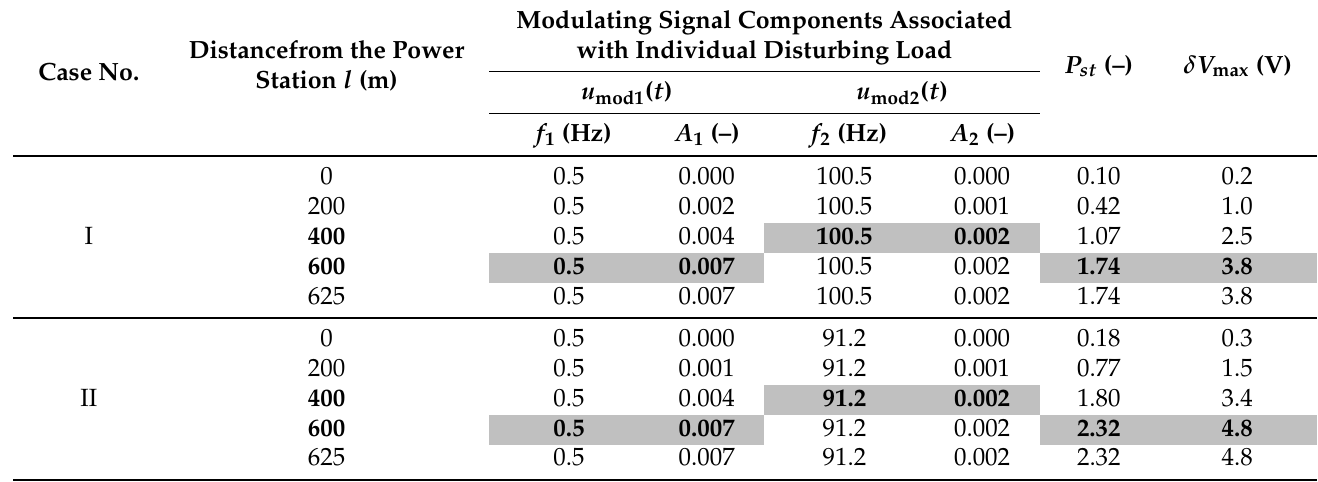
Table 7. The numerical simulation research results for Line